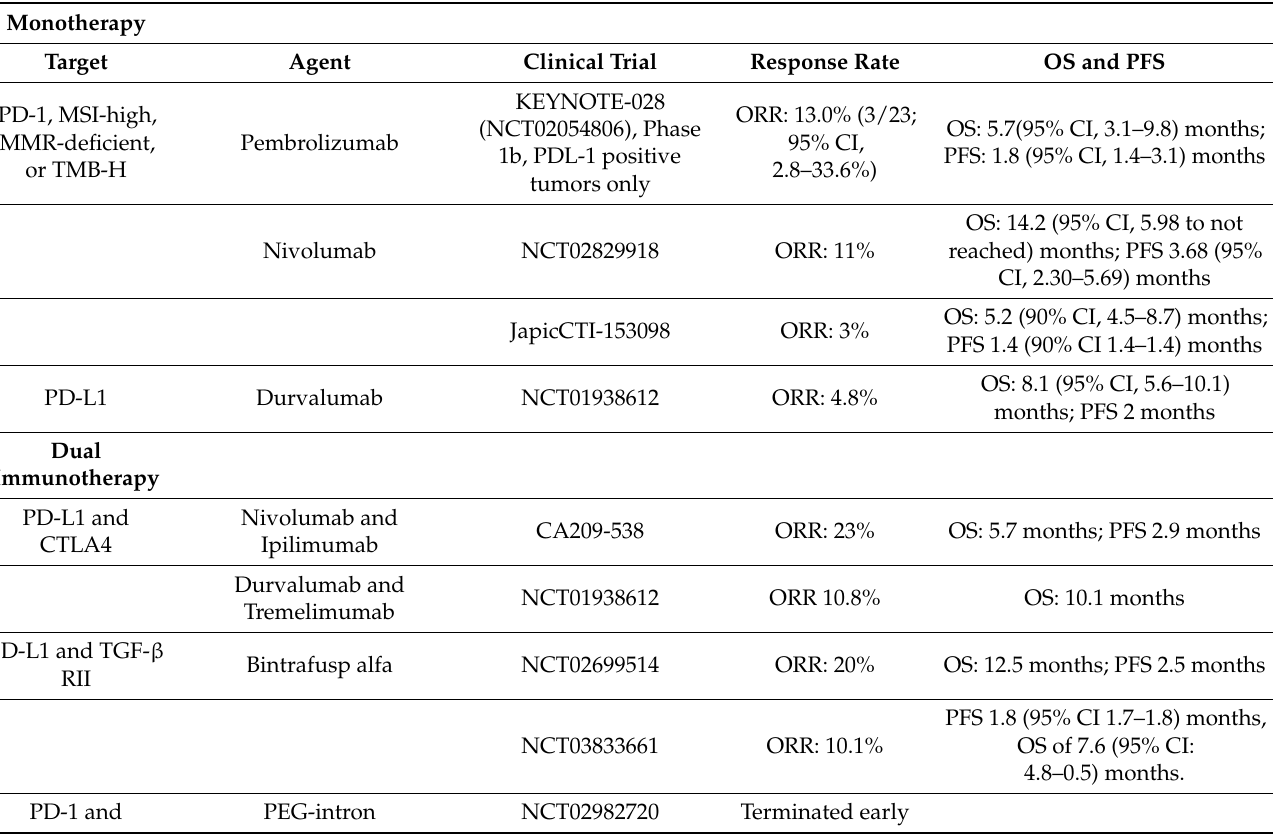
Table 3. Completed immunotherapy clinical trials in